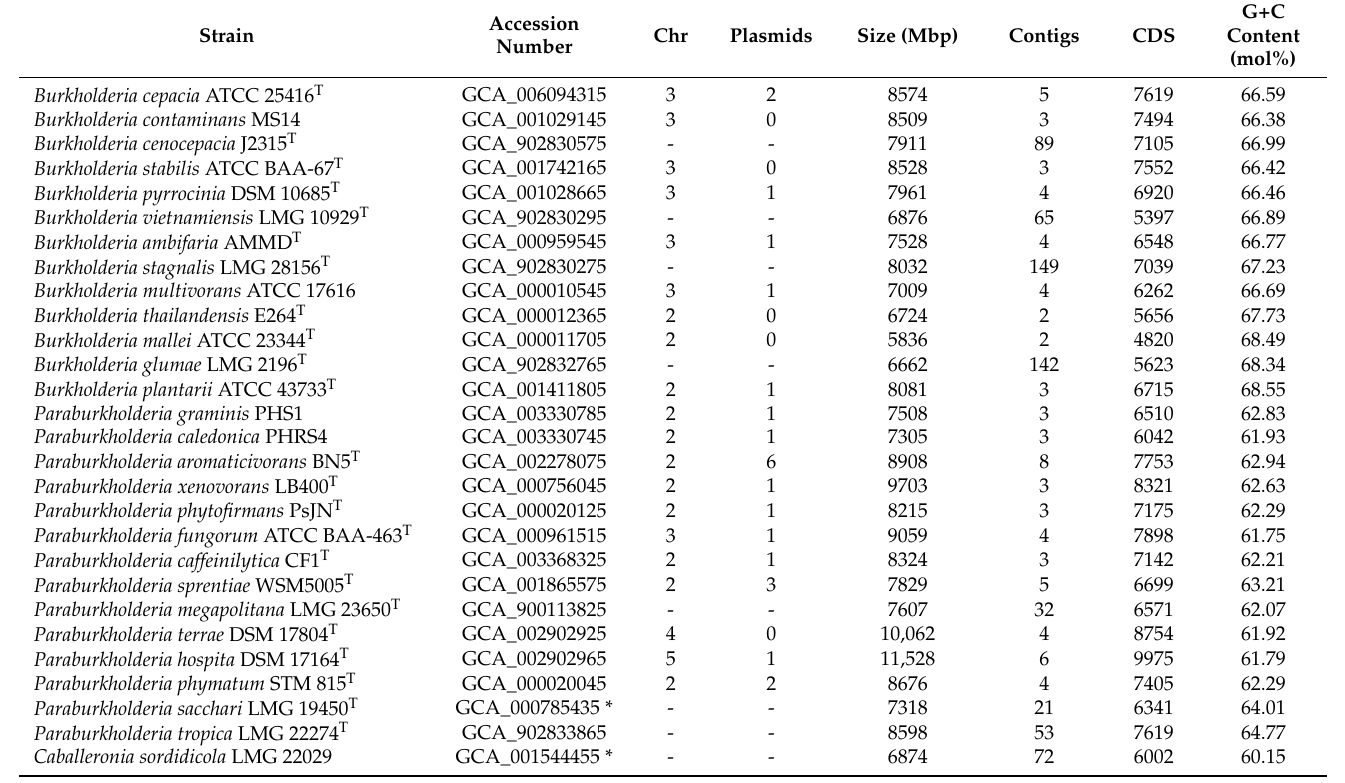
Table 2. Genome characteristics of 37 Burkholderia sensu lato type and representative strains.